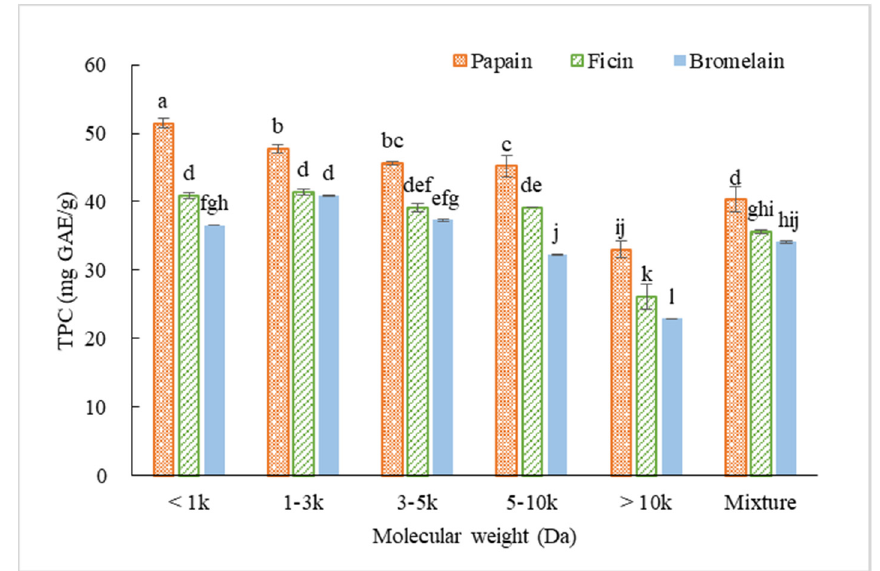
Figure 6. Total phenolic content (TPC) of different peptide fractions (1 mg/mL) ultrafiltrated from CGM hydrolysates prepared by papain (3 h), ficin (4 h), and bromelain (4 h). (Different letters indicate significant differences at p < 0.05 for each enzyme).